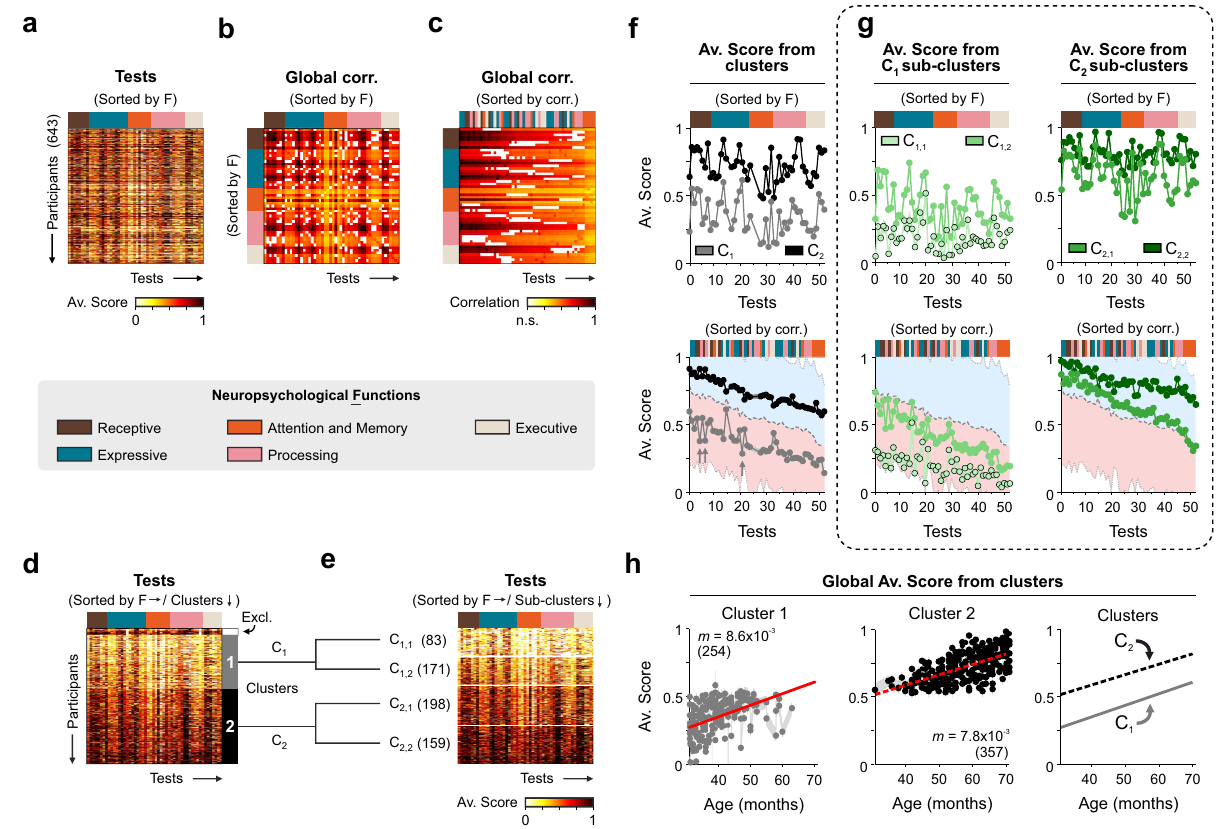
Figure 1. Classifying Latin-American children’s performance across distinct tasks and neuropsychological functions. ( a ) Scores from a battery of 52 neuropsychological tests performed on 643 Latin-American children. Grouping of tests into receptive (walnut brown), expressive (mosaic blue), attention/memory (orange), processing (flamingo pink), and executive (cloud cream yellow) functions (color bar on the bottom of the heatmap). ( b ) Peak global cross-correlations across tasks sorted by functions or ( c ) by the summed correlations across tasks for the entire data set. Filled pixels represent values that cannot be explained by chance ( P < 0.05). ( d ) Classification of children into two main clusters (C 1 and C 2 ). ( e ) Further partition of the two main clusters into two sub-clusters each (C arrows point to three tests that exhibited average values below those expected if they followed the trend of scores sorted by correlation (test #5: Left hand recognition; #7: Following oral instructions; #21: Naming body parts). ( g ) Average scores from each sub-cluster sorted by neuropsychological functions and by the summed correlations (same arrangement as in f ). Shaded areas in panels F and G depict the regions covering 1.5 standard deviations away from the mean of the population, which is shown as a grey dotted line. ( h ) Global scores (i.e., the average of all tests) as a function of age for C 1 and C 2 . Linear fits display similar slopes but different intercepts for each cluster. Number of participants in